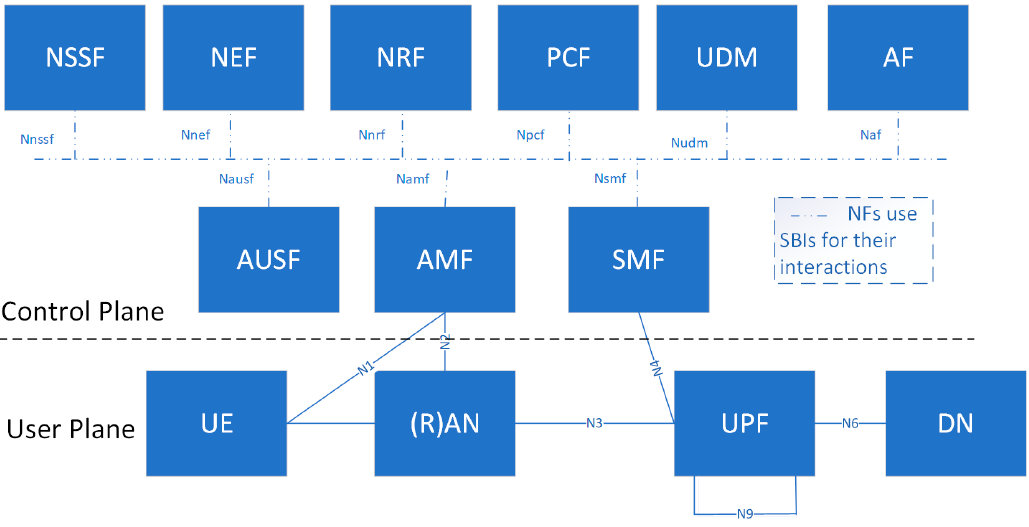
Figure 5. Service ‐ based representation of the 5G non ‐ roaming system architecture. Figure 5. Service-based representation of the 5G non-roaming system